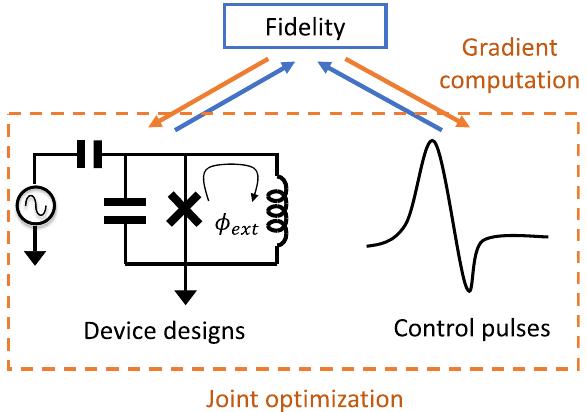
Fig. 1 Illustration of joint optimization in circuit quantum electrodynamics systems. Both device designs and control pulses contain many parameters, and together they determine the fi delity of the quantum operations. In this work, we consider the problem of optimizing them together.